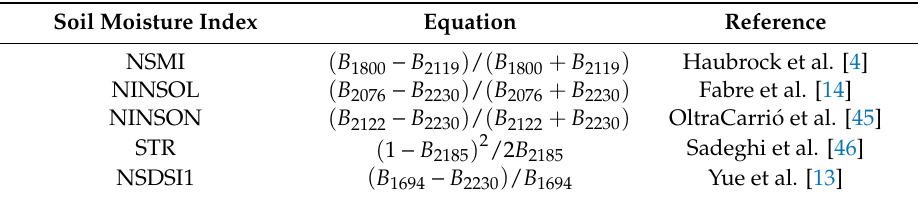
Table 3. Soil moisture indices found in the literature.